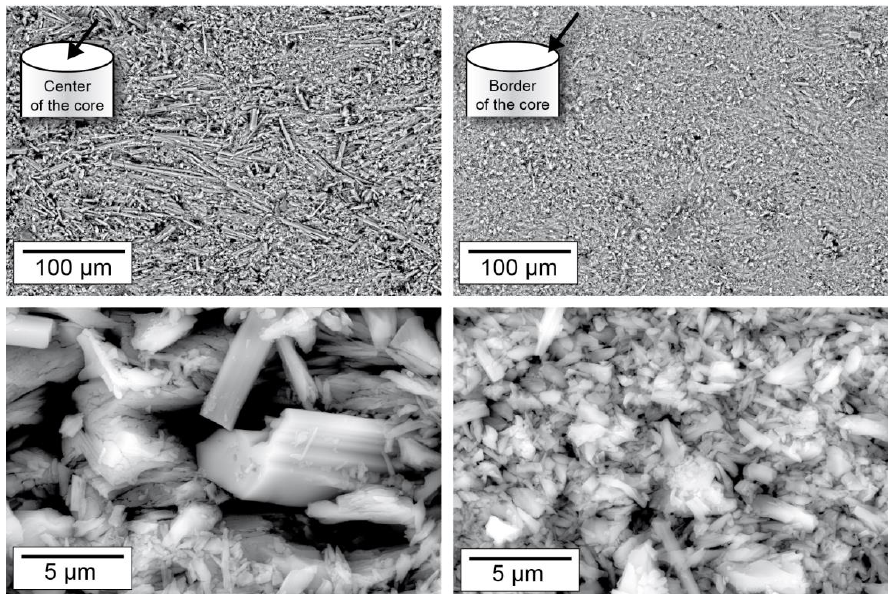
Figure 6. Electron microscopic examination of the microstructure of the gypsum sample after the exposure experiment (100 °C, 2 h) at the edge of the core and in its center.